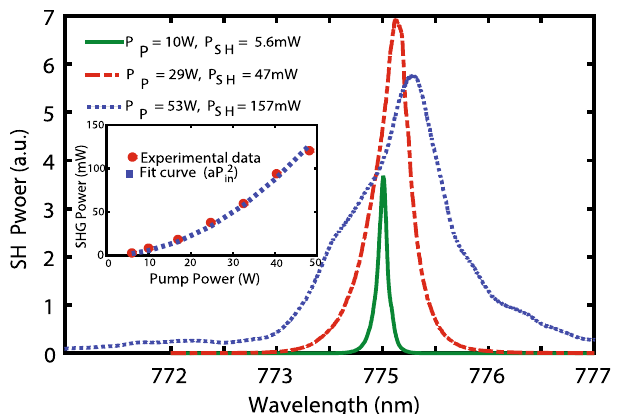
Figure 5. SH spectra for 3 pump powers shown in Fig. 3(a). The inset shows output SH power in mW versus input FH pump power in W. Quadratic SH power with respect to the pump power is realized and the a coefficient is